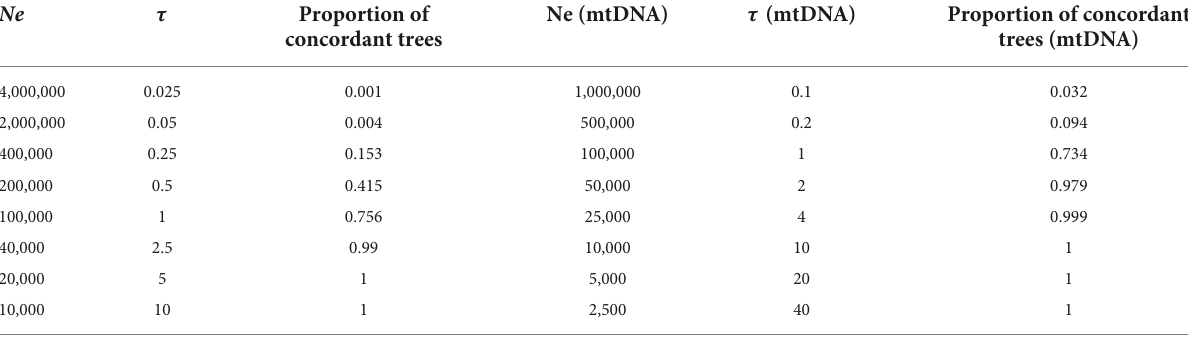
TABLE 2 Results of in silico experiment exploring the importance of divergence time in generating/preventing the existence of monophyletic groups (concordant gene trees). Ne τ Proportion of Ne (mtDNA) τ (mtDNA) concordant trees